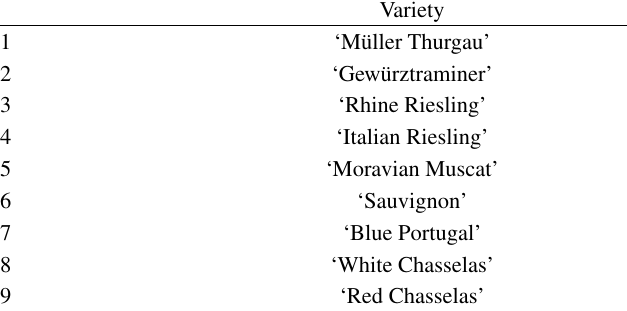
Table 1 - List of selected varieties